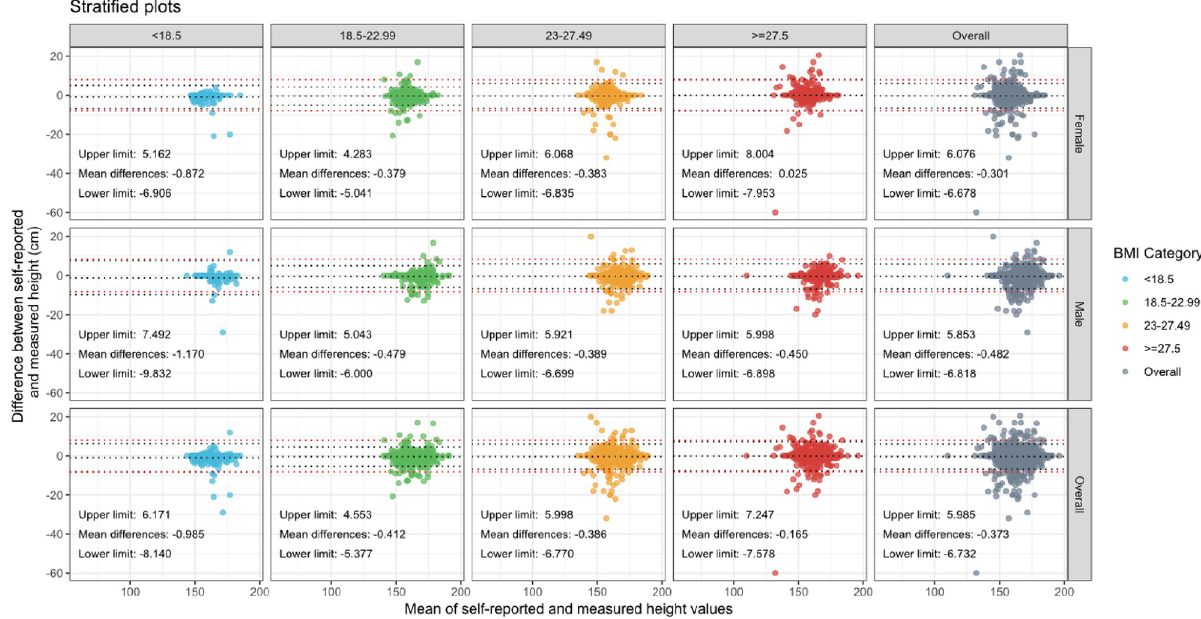
Fig 1. Bland-Altman plots showing the difference between self-reported and measured height against mean of self-reported and measured height by gender and BMI. Mean differences and the limits of agreement are denoted in each panel and are represented by black dotted lines. The definition of “accurate” for the purpose of this study are within 5% of mean participant height which is denoted with red dotted lines for each category.